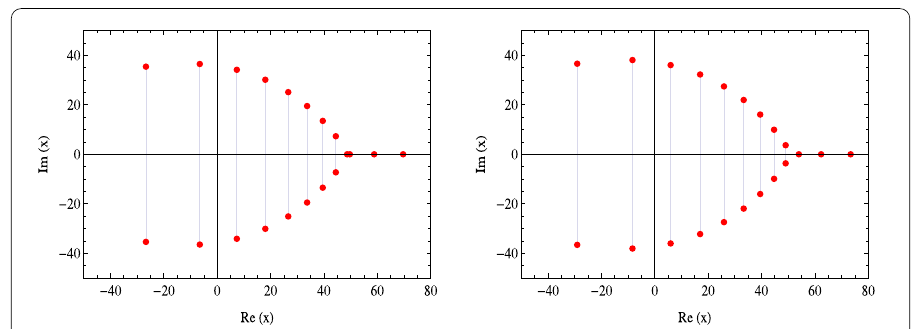
Figure 4 Zeros of LTEP L e n ( x , b ) have Im( x ) = 0 reflection symmetry